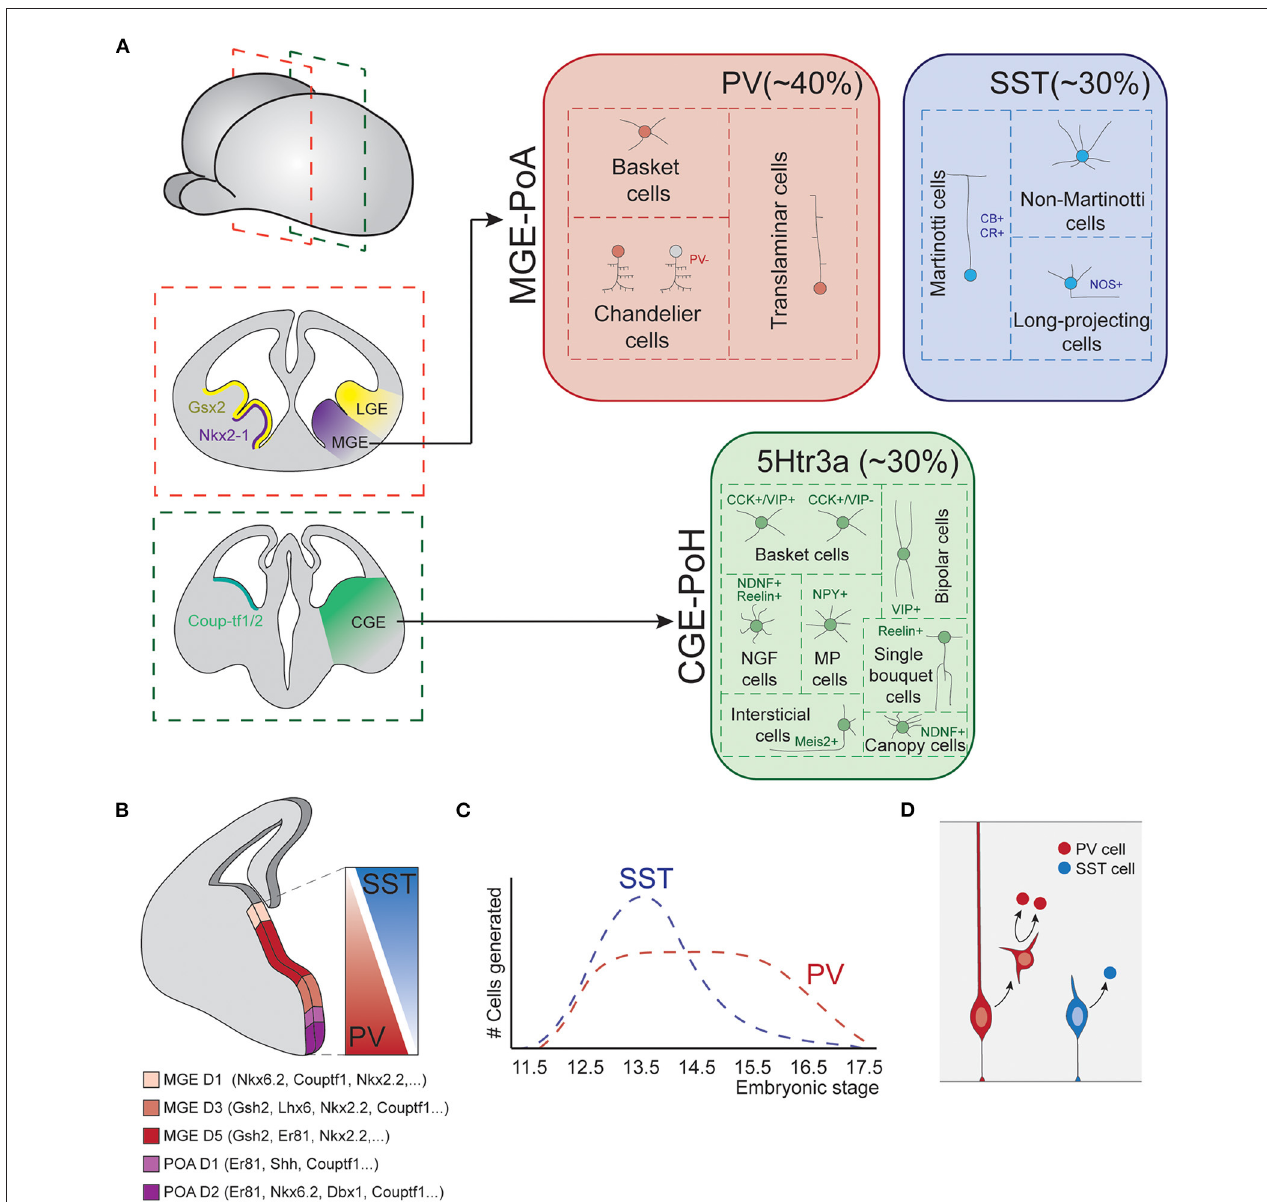
FIGURE 3 | Fate-specification of cortical interneurons. (A) The spatially organized expression of specific combinations of transcription factors subdivides the subpallium into different structures. Among those, the MGE and POA generate interneurons of both PV and SST classes. The CGE and POH are responsible for the generation of all types of 5Htr3a neurons. (B) MGE is further subdivided into spatial domains in the dorsoventral axis, each of these domains is defined by differential gene expression patterns. Such spatial patterning relates to the production of different interneuron types, as SST and PV cells largely derive from dorsal and ventral MGE respectively. (C) Temporal biases in interneuron origin. SST cells are mostly produced during early neurogenesis, while PV cell production remains nearly constant throughout the entire neurogenic window. (D) Progenitor cell mode of division also influences interneuron fates. Direct neurogenesis from apical progenitors mostly produces SST cells, while basal progenitor divisions mostly generate PV fates. MGE, medial ganglionic eminence; POA, preoptic area; CGE, caudal ganglionic eminence; POH, Preoptic-hypothalamic border domain; PV, parvalbumin; SST, somatostatin; CB, calbindin; CR, calretinin; NOS, nitric oxide synthase; CCK, cholecystokinin; VIP, vasointestinal peptide; NDNF, neuron derived neurotrophic factor; NPY, neuropeptide